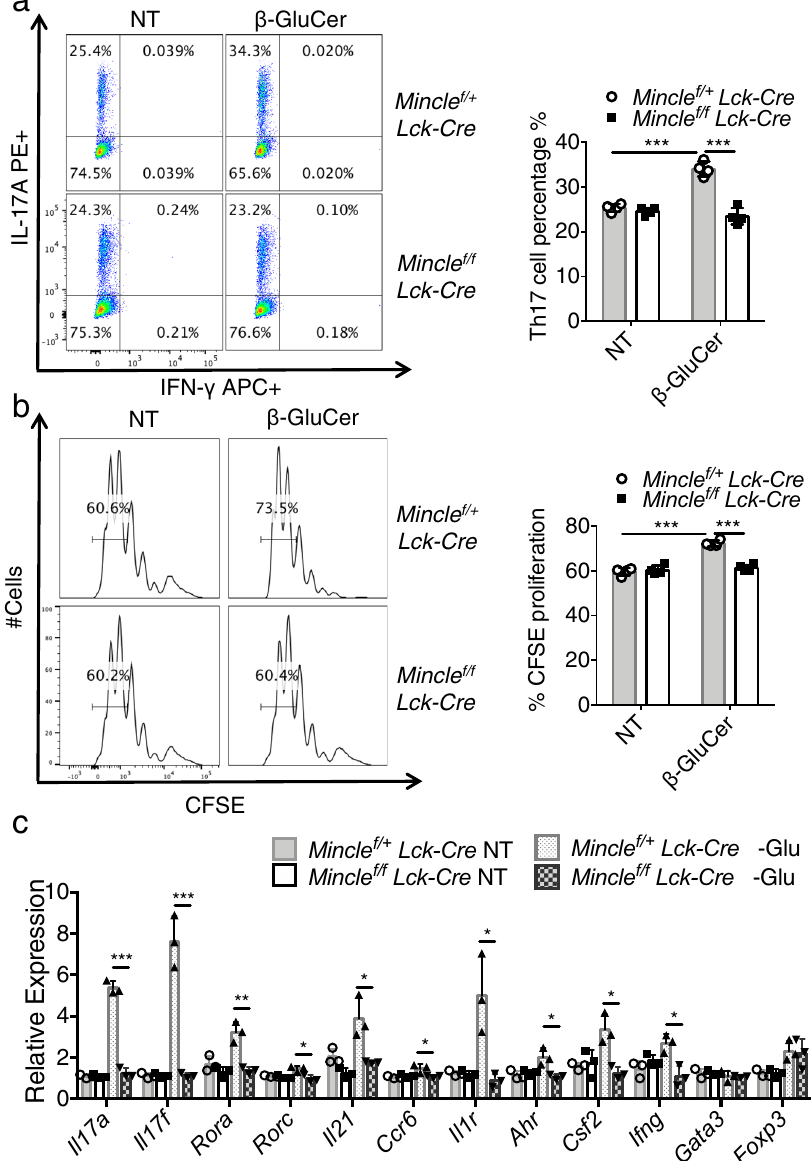
Fig. 4 Mincle activation promotes T H 17 differentiation. a Flow cytometric analysis of IL-17A and IFN γ from Mincle f/ + Lck-Cre and Mincle f/f Lck-Cre T H 17 polarized with or without β -glucosylceramide (5 μ g/ml) stimulation, n = 4 biological replicates. b CFSE staining of T H 17 cells polarized with or without β -glucosylceramide (5 μ g/ml). Data are presented as mean fl uorescent intensity, n = 4 biological replicates. c Real-time PCR of mRNA of in fl ammatory genes in T H 17 cells polarized with or without β -glucosylceramide (1 μ g/ml), n = 3 biological replicates. Expression was normalized to expression of β -actin. * p < 0.05, ** p < 0.01 *** p < 0.001 (Two sided student ’ s t test). Data are represented as mean ± SD. Exact P values for asterisks (from left to